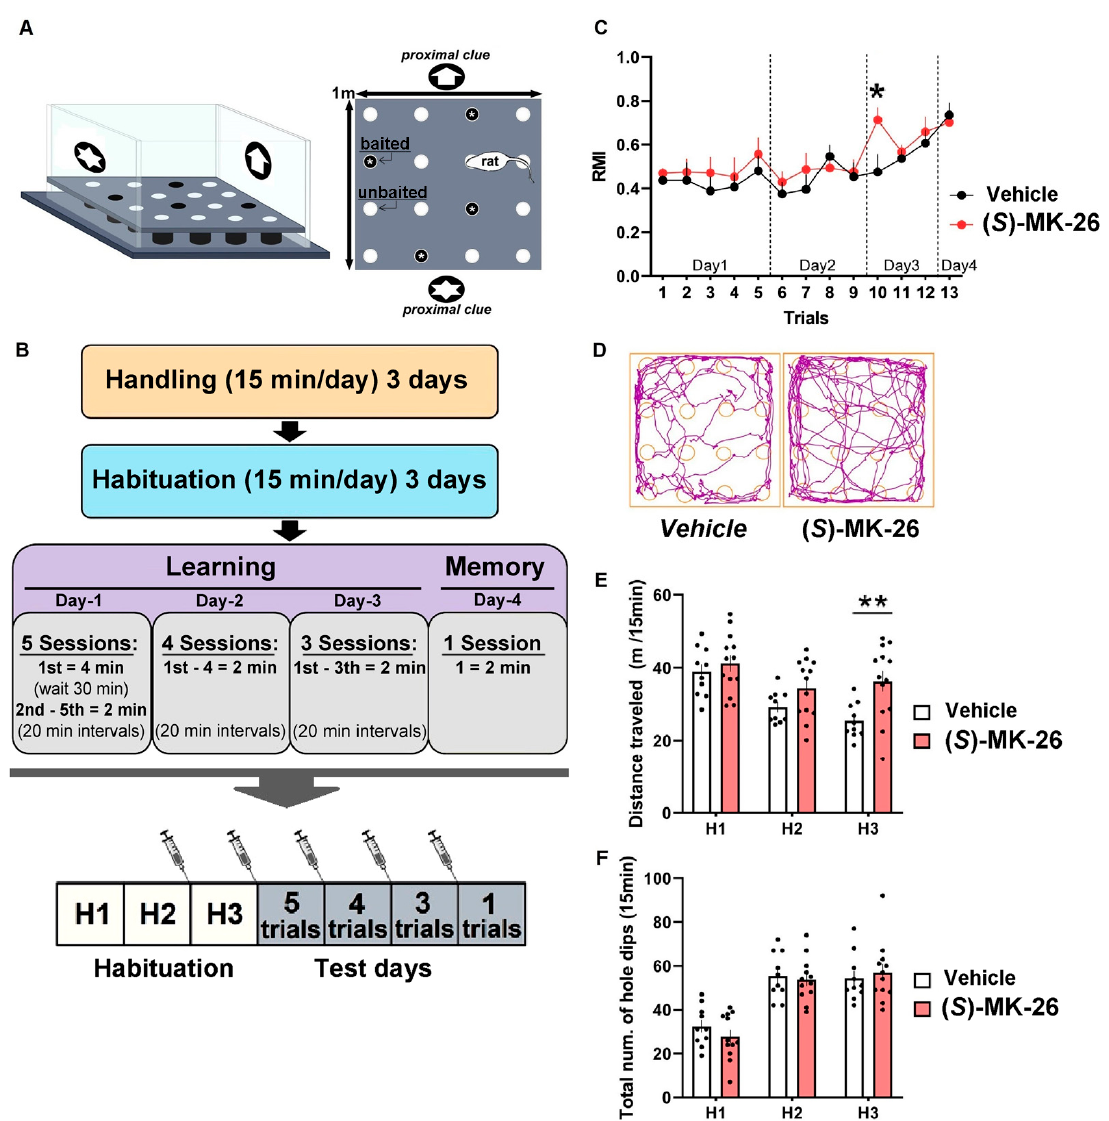
Figure 7. ( S )-MK-26 has only lesser effects on reference memory. ( A ) Schematic of the hole-board maze, a paradigm for the evaluation of spatial learning and memory (left) with depictions (right) of maze dimensions (an animal at approximated size scale relative to the size of the hole-board arena is sche- matized); localization of proximal clues; spatial distribution of the holes; and representation of baited and unbaited holes (see also Materials and Methods). ( B ) Flow diagram representing the methodological strategy used during the preparation and implementation of the hole-board test. ( C ) Performance of aged rats (19 months old) in spatial memory task over thirteen trials (over 4 days) in the ( S )-MK-26-treated and control vehicle-treated control groups showed significance though frail enhancement of reference memory induced by ( S )-MK-26 ( p = 0.0202) detected by Sidak’s test following repeated-measures ANOVA). ( D ) Representative traces of locomotor activity recorded during the H3 session in each treatment group. ( E ) ( S )-MK-26 increased distance travelled in 15 min habituation session ( p = 0.0053, unpaired t test) (H1, H2—drug free; H3—first treatment). ( F ) Total number of hole dips in the 15 min habituation sessions. Values are presented as mean ± SEM; n = 10–12; * p < 0.05, ** p < 0.01.